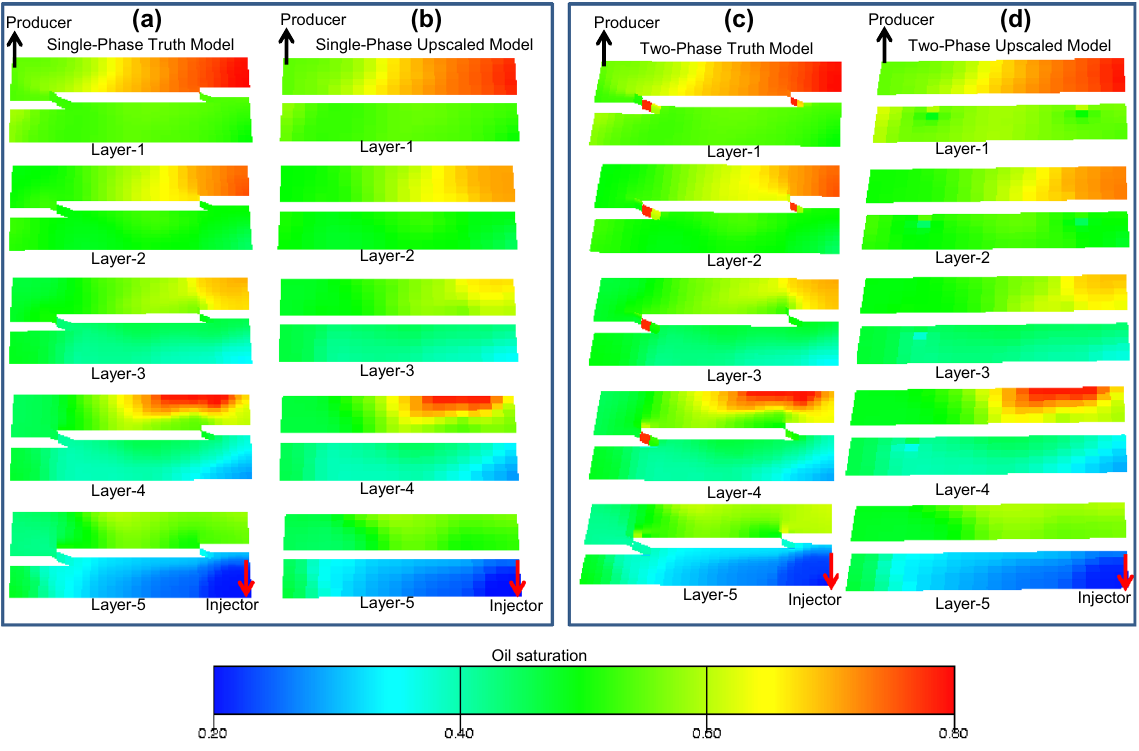
Figure 7. Oil saturation maps at 5 years for each layer of ( a ) the single-phase truth model, ( b ) the single-phase upscaled model, ( c ) the two-phase truth model, and ( d ) the two-phase upscaled